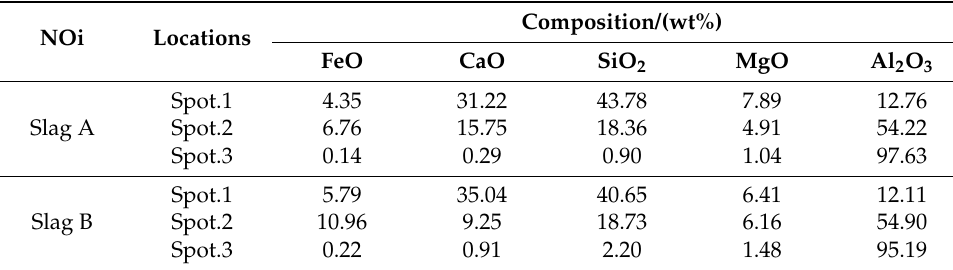
Figure 7. Line scanning results of slag A. Table 3. EDS composition at different